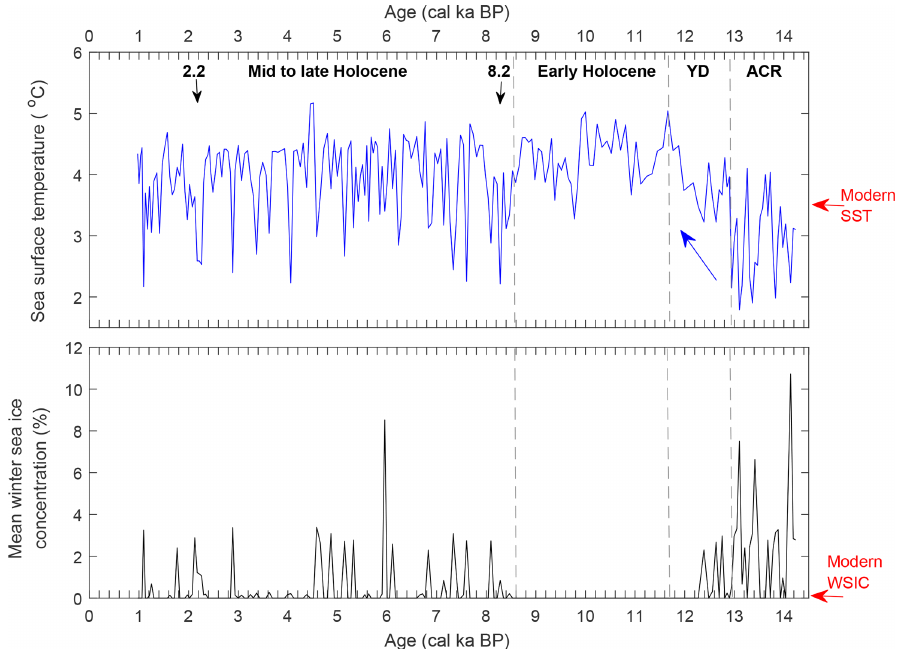
Figure 4. Reconstructed mean summer (January–March) sea surface temperature and mean winter (September) sea ice concentrations for core COR1GC. Key periods discussed are highlighted, along with significant centennial cool events at ca. 8.2 and 2.2ka, as identified by the SiZer analysis (Fig. 5). The modern average summer SST at 10m depth is 3.5 ◦ C (Locarnini et al., 2013) marked on the graph, while the modern winter sea ice concentration (WSIC) is marked as 0 as the sea ice limit is at 59 ◦ S (Park et al., 1998; Parkinson and Cavalieri,